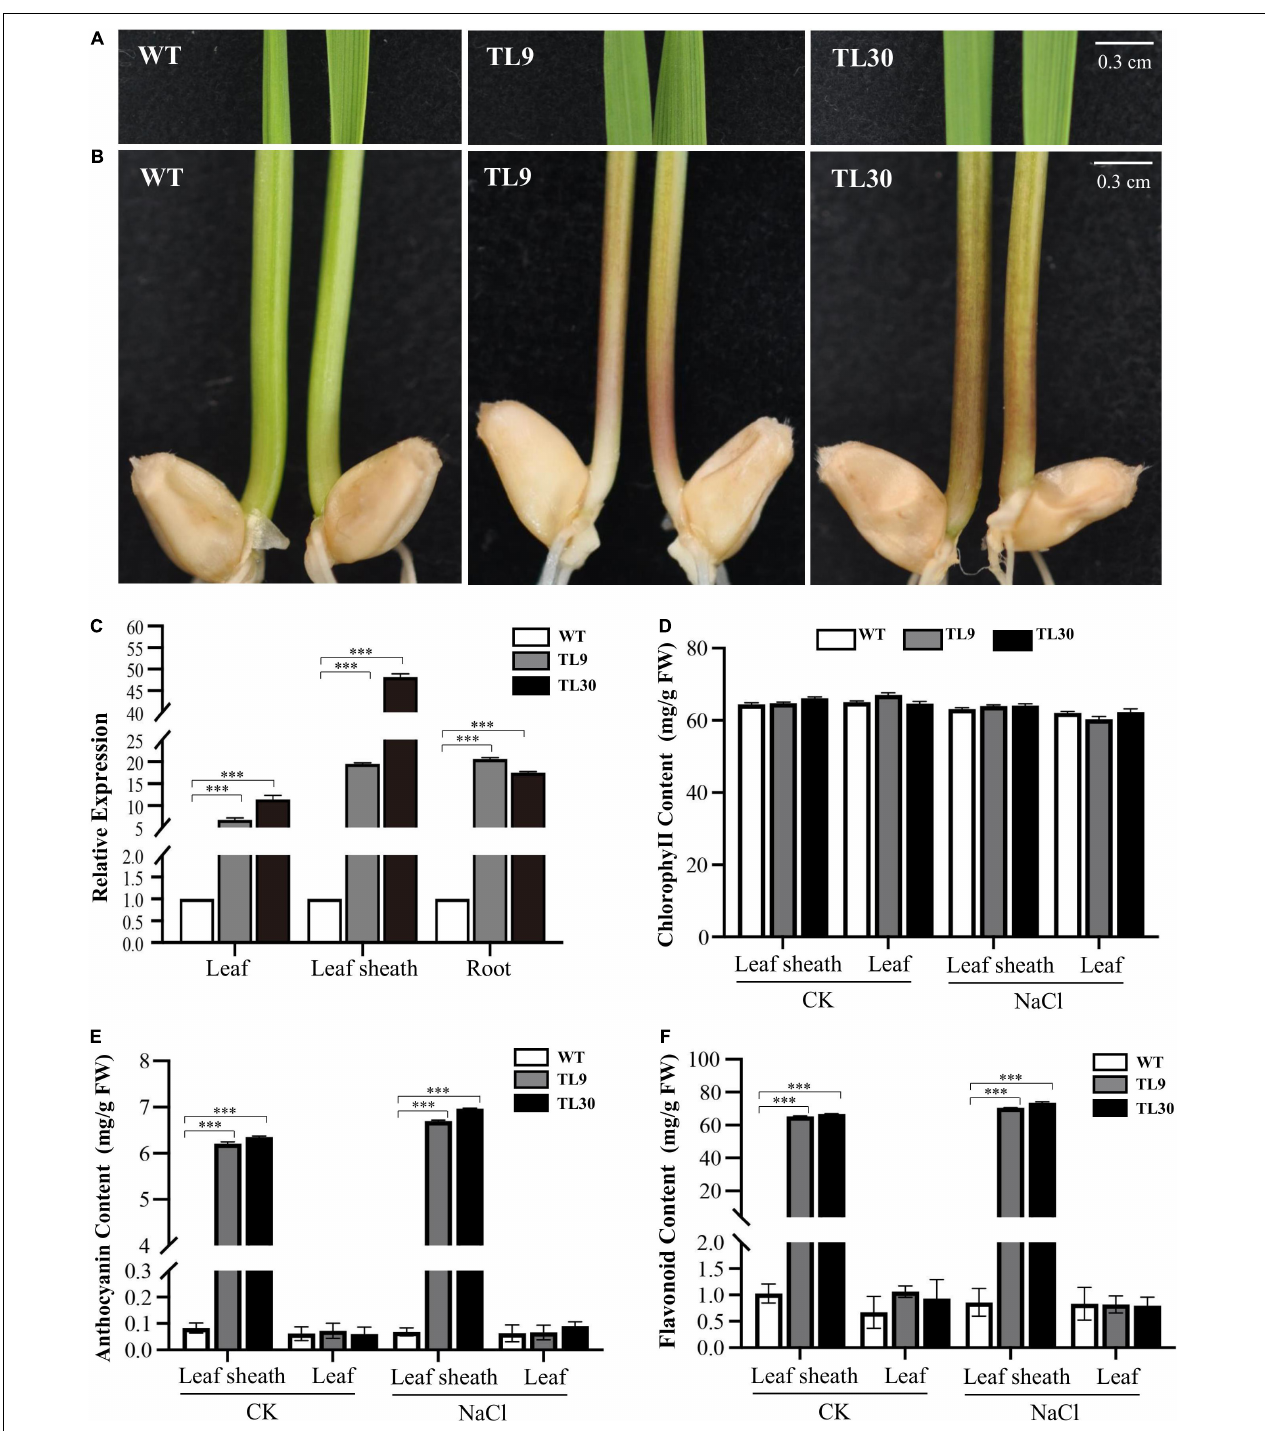
FIGURE 1 | Expression of EsMYB90 gene enhanced contents of anthocyanin and total flavonoid in leaf sheath tissues of transgenic wheat plants. The color phenotype of leaves (A) and leaf sheaths (B) in TL9 and TL30 transgenic lines compared with wild type (WT), from 10-day-old wheat plants. Bars:0.3 cm. (C) Expression analysis of EsMYB90 in leaf, leaf sheath, and root tissues of transgenic lines compared to WT by quantitative real-time (qRT)-PCR. Y -axis indicates the relative expression of the EsMYB90 gene calculated by 2 − (cid:49)(cid:49) CT . Tatub4 ( tubulin beta-4 , TraesCS5A02G416400 ) was used as an internal control gene. Contents of chlorophyll (D) , anthocyanin (E) , and total flavonoid (F) in leaf and leaf sheath tissues of transgenic lines compared with WT. Student’s t- test values are indicated as ∗∗∗ P < 0.001 and vertical bars indicate the SEs of three biological replicates.